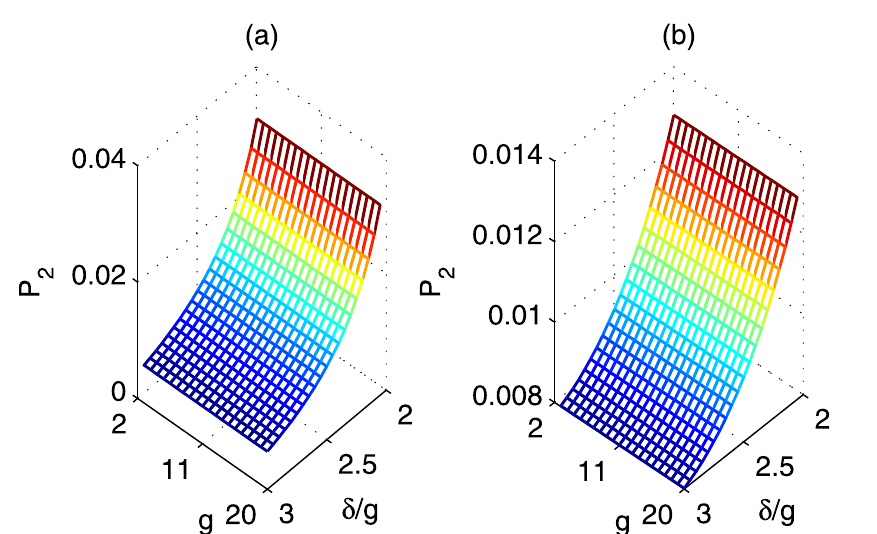
Figure 8. The probability P 2 . ( a ) The first case; ( b ) The second